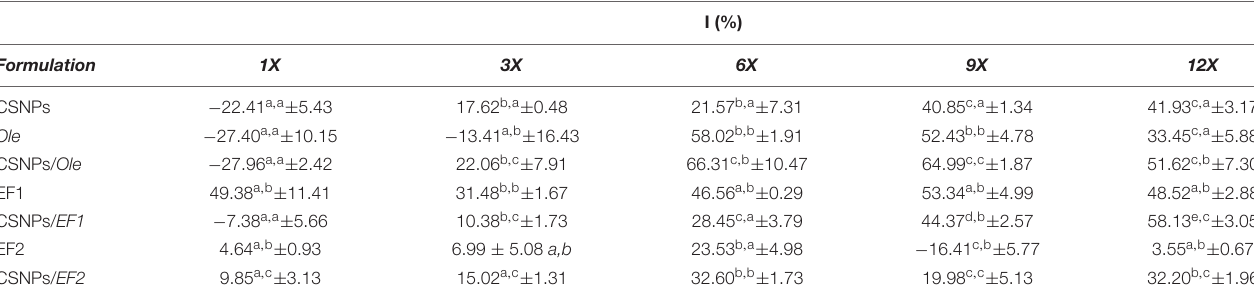
TABLE 5 | In vitro Fusarium proliferatum (AACC0215) percentage of growth inhibition (% I) in the presence of pure chitosan nanoparticles (CSNPs), oleuropein ( Ole ), leaf extract 1 ( EF1 ) and leaf extract 2 ( EF2 ) free in solution or encapsulated into